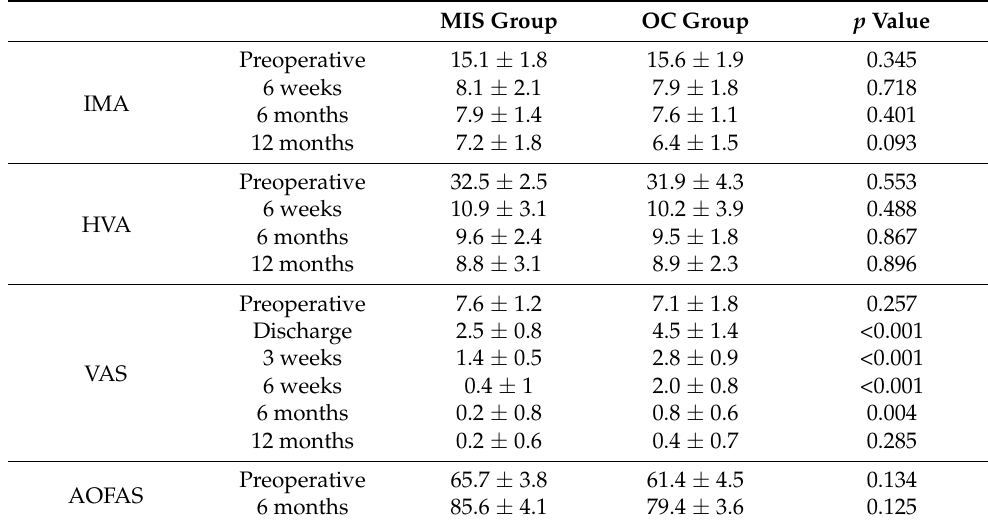
Table 2. Clinical data of both